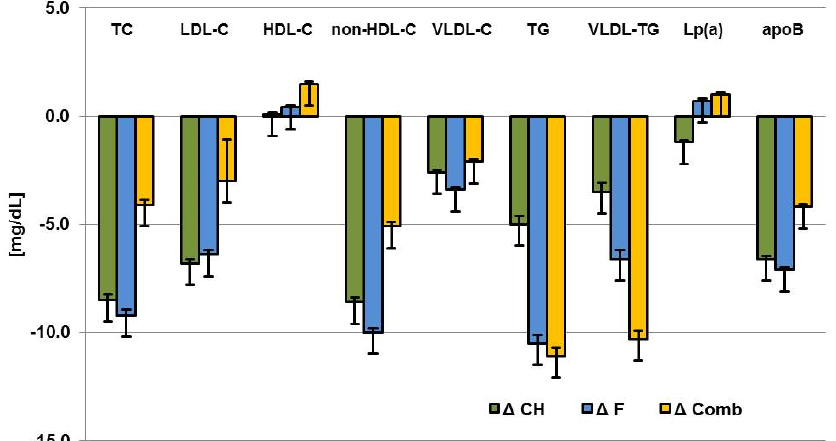
Figure 4. Changes in fasting plasma lipid levels and apoB concentration from baseline in subgroups (mg/dL). Values are mean ± SEM. CH: carbohydrates reduced in walnut-phase ( n = 62); F: Fat reduced in walnut-phase ( n = 65); Comb: both fat and carbohydrates reduced in walnut-phase ( n = 67). TC, total cholesterol; LDL-C, low density lipoprotein-cholesterol; HDL-C, high density lipoprotein-cholesterol; VLDL-C, very low density lipoprotein-cholesterol; TG, triglycerides; Lp (a), lipoprotein (a); apoB, apolipoproteinB.